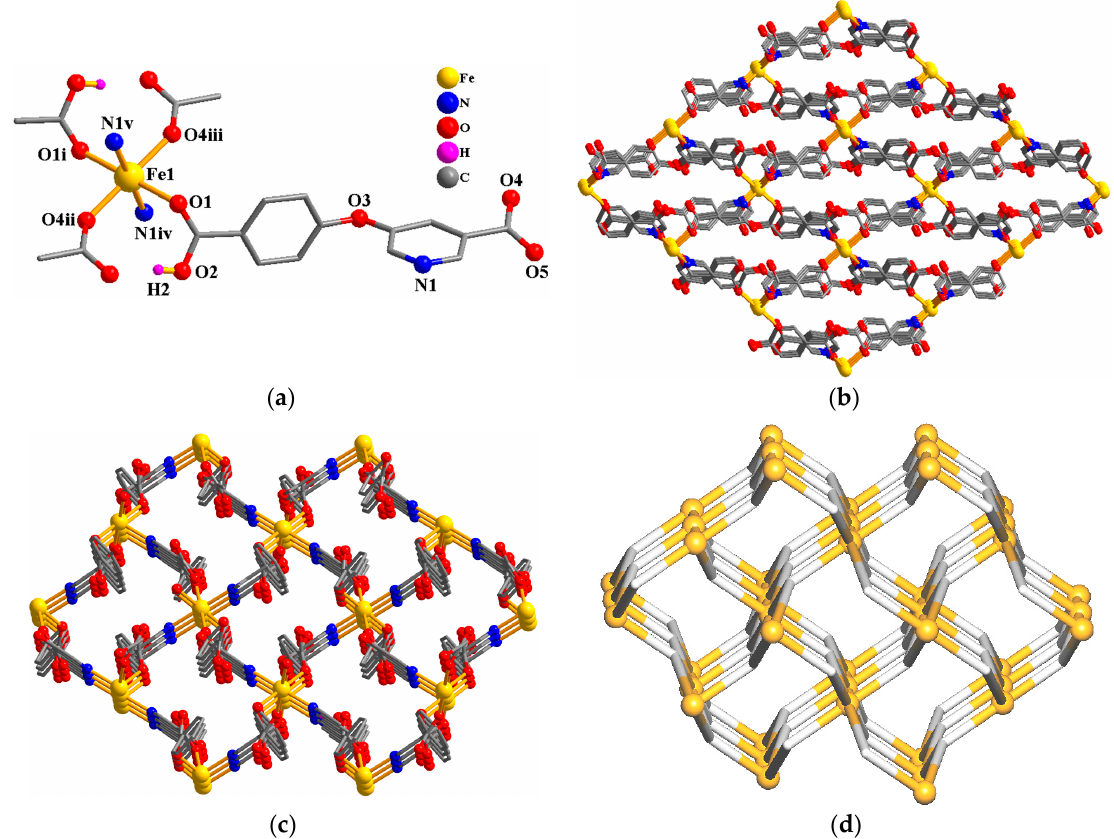
Figure 1. Different structural representations of 1 . ( a ) Connectivity and coordination sphere of the Fe1 center; hydrogen atoms are not shown with an exception of H in COOH. Symmetry operators: i = – x + 1, – y + 1, – z ; ii = x , y , z – 1; iii = – x + 1, – y +1, – z + 1; iv = – x + 1/2, y + 1/2, – z + 1/2; v = x + 1/2, – y + 1/2, z – 1/2. ( b , c ) Three-dimensional metal-organic network along the a and c axis, respectively. ( d ) Topological view of a 3D coordination polymer displaying a 3,6-connected binodal underlying net of the rtl (rutile) topological type. View along the c axis; colors: centroids of 3-connected μ 3 -Hcpna – nodes (gray), 6-connected Fe1 nodes (orange balls).